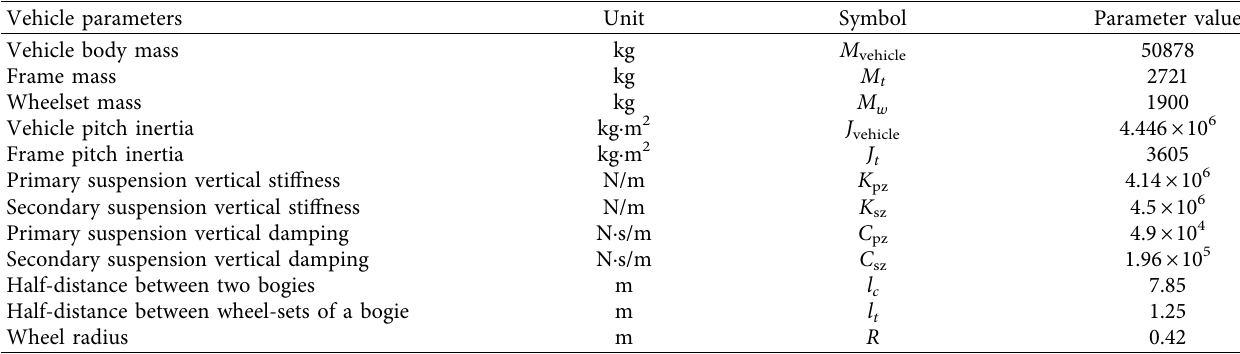
Figure 2: Calculation model and procedures of fatigue life of fastener Elastic rail clips: (a) metro vehicle-track coupling dynamic model; (b) refined model of fastener system; (c) flow chart of calculation of fatigue life. Table 1: Metro vehicle